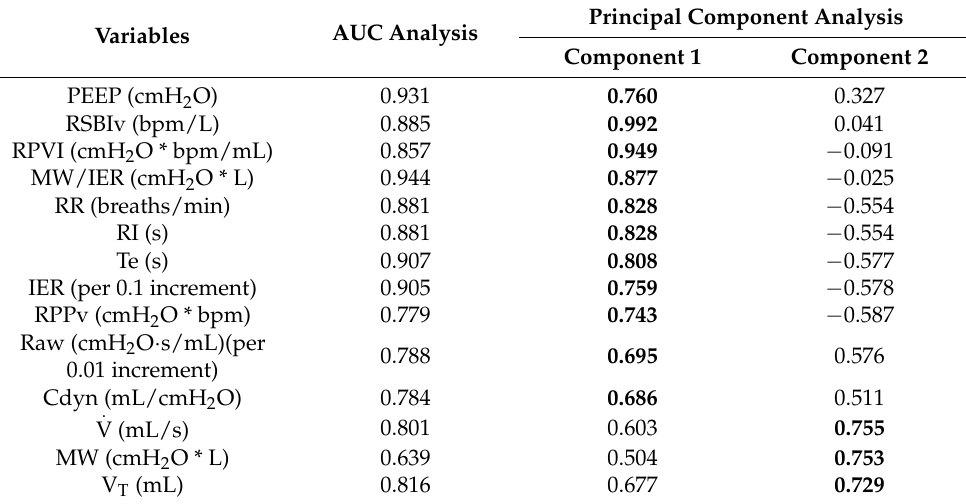
Table 3. The areas under the ROC curves (AUCs) of mechanical ventilator parameters and variable coefficients in principal component analysis for the development of ARDS.